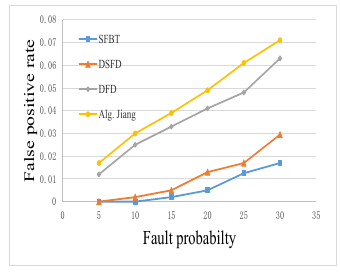
Figure 7. False positive rate